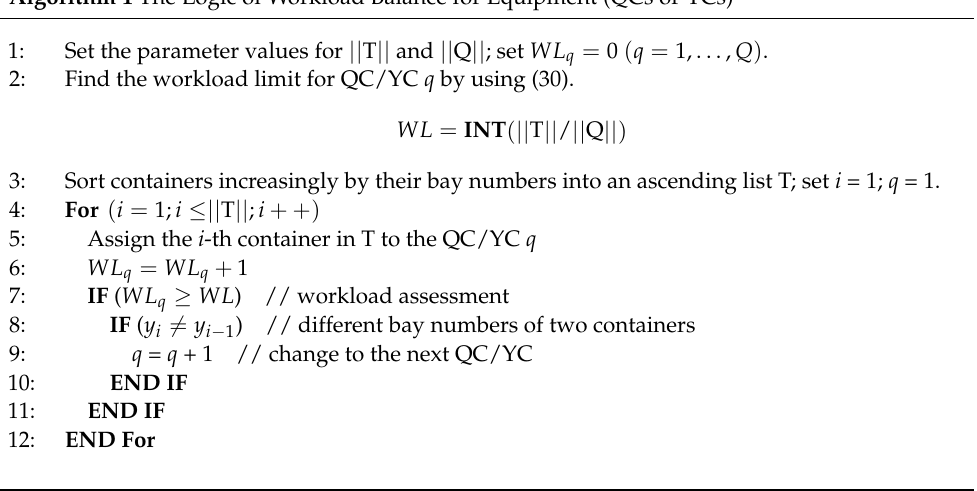
Algorithm 1 The Logic of Workload Balance for Equipment (QCs or